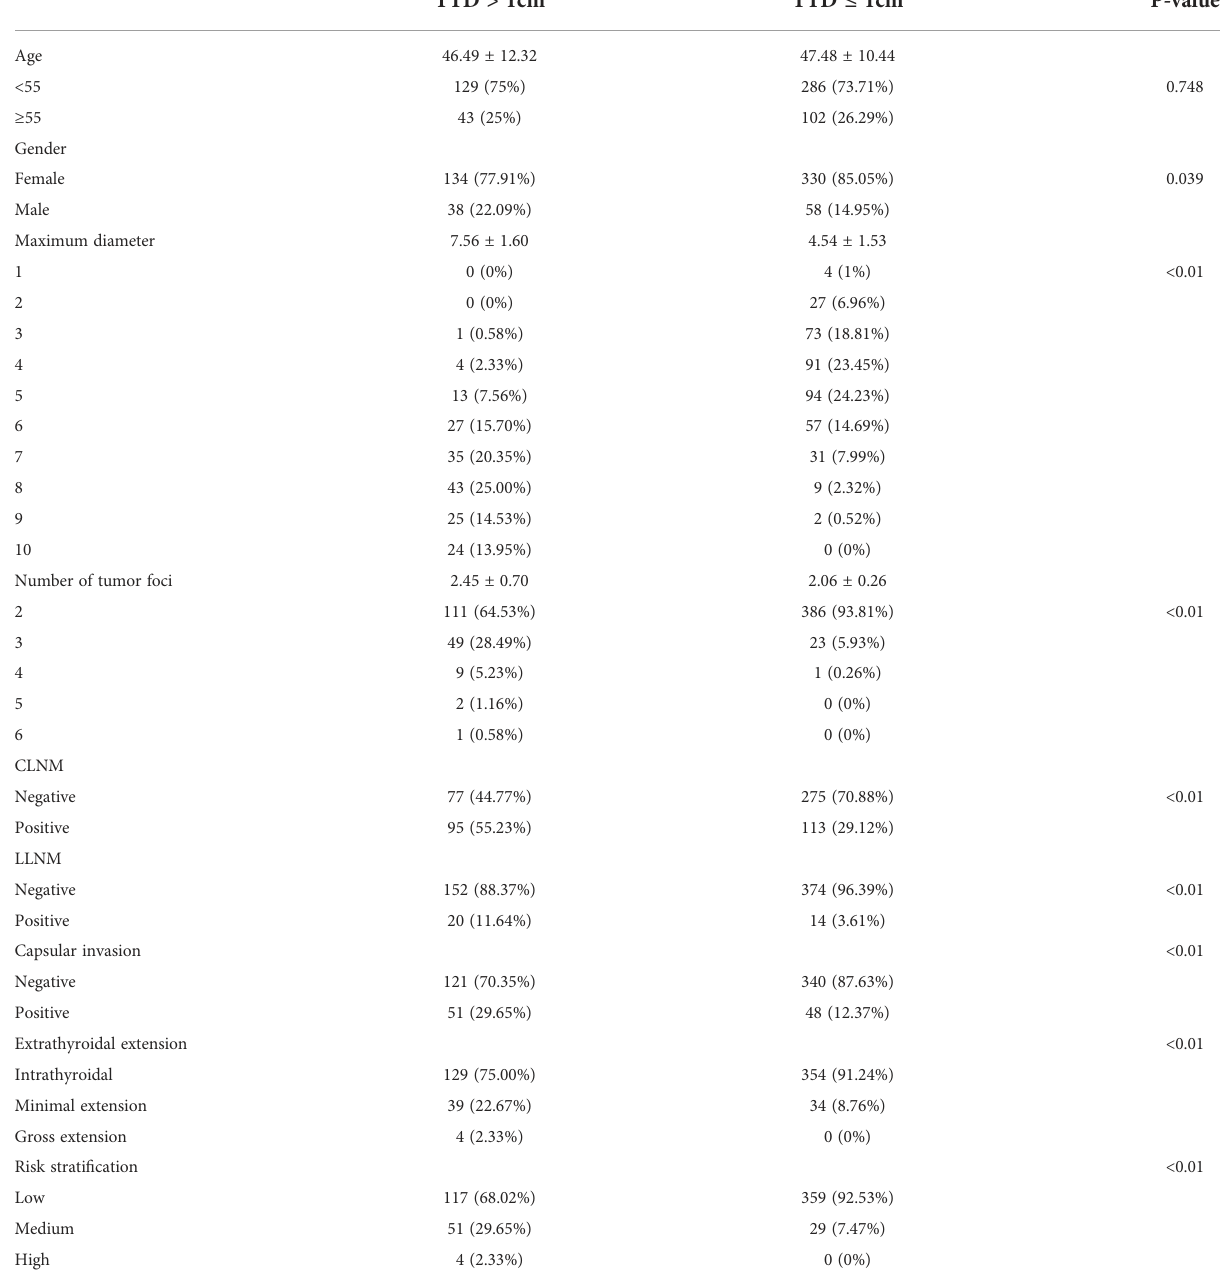
TABLE 1 Comparison of baseline characteristics between multifocal PTMC with TTD >1 cm and TTD ≤ 1 cm before